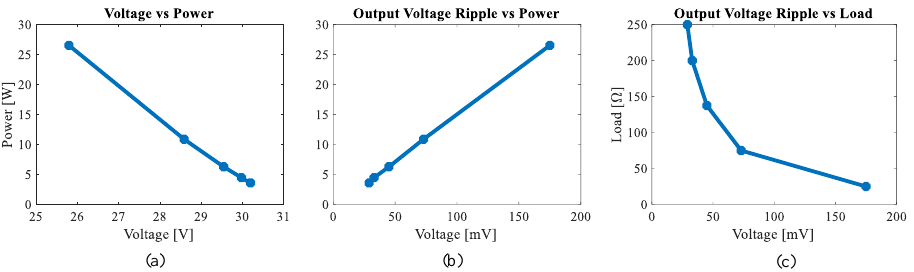
Figure 11. Effect of load change on output voltage regulation: ( a ) voltage vs. Power ( b ) output voltage ripples vs. power ( c ) output voltage ripples vs